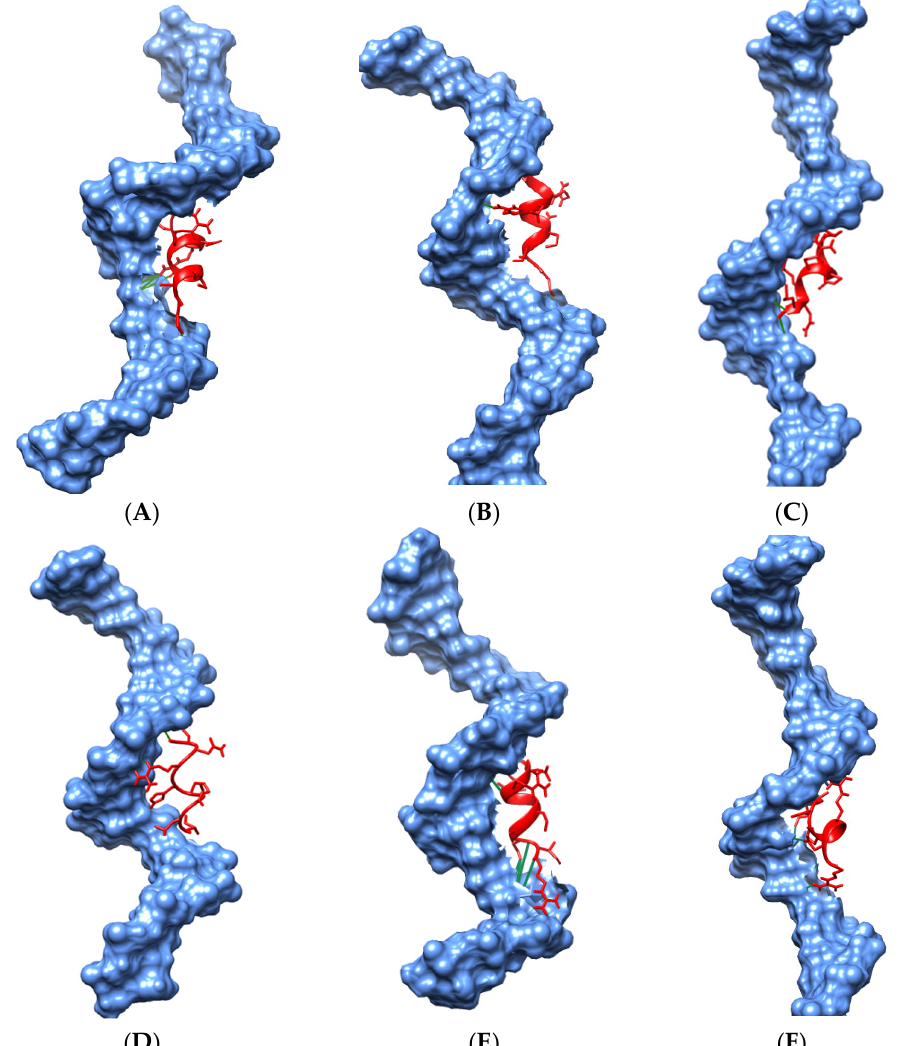
Figure 7. The binding site of DNA molecule with surface representation in molecular docking com- plexes of TP63–DNA, showing both wild-type and mutant proteins. ( A – F ) represent the following: ( A ) G349, ( B ) E349, ( C ) R319, ( D ) H319, ( E ) C347, and ( F ) F347 complexed with DNA. Here, blue color indicates DNA and red color denotes TP63 protein.